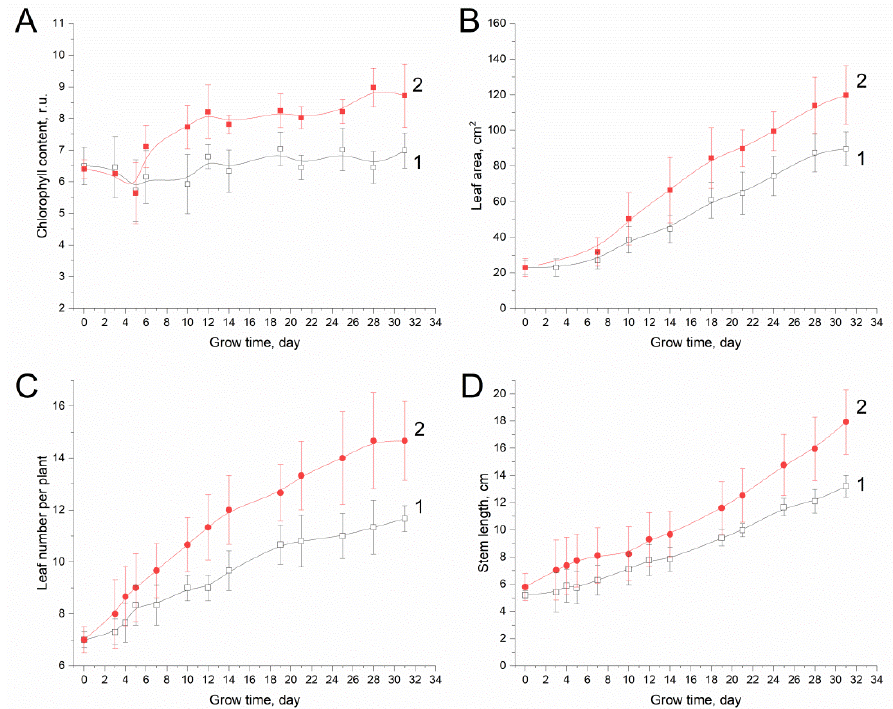
Figure 3. Dependence of relative chlorophyll content ( A ), total area ( B ) and number ( C ) of leaves and stem length ( D ) on grow time of plants under glasses coated with fluoroplate polymer without (1) or with (2) photoconversion nanoparticles. The data are the means of at least 11 measurements, with the standard error of the mean. Relative chlorophyll content value is the mean of 4–10 measurements on at least 11 plants.